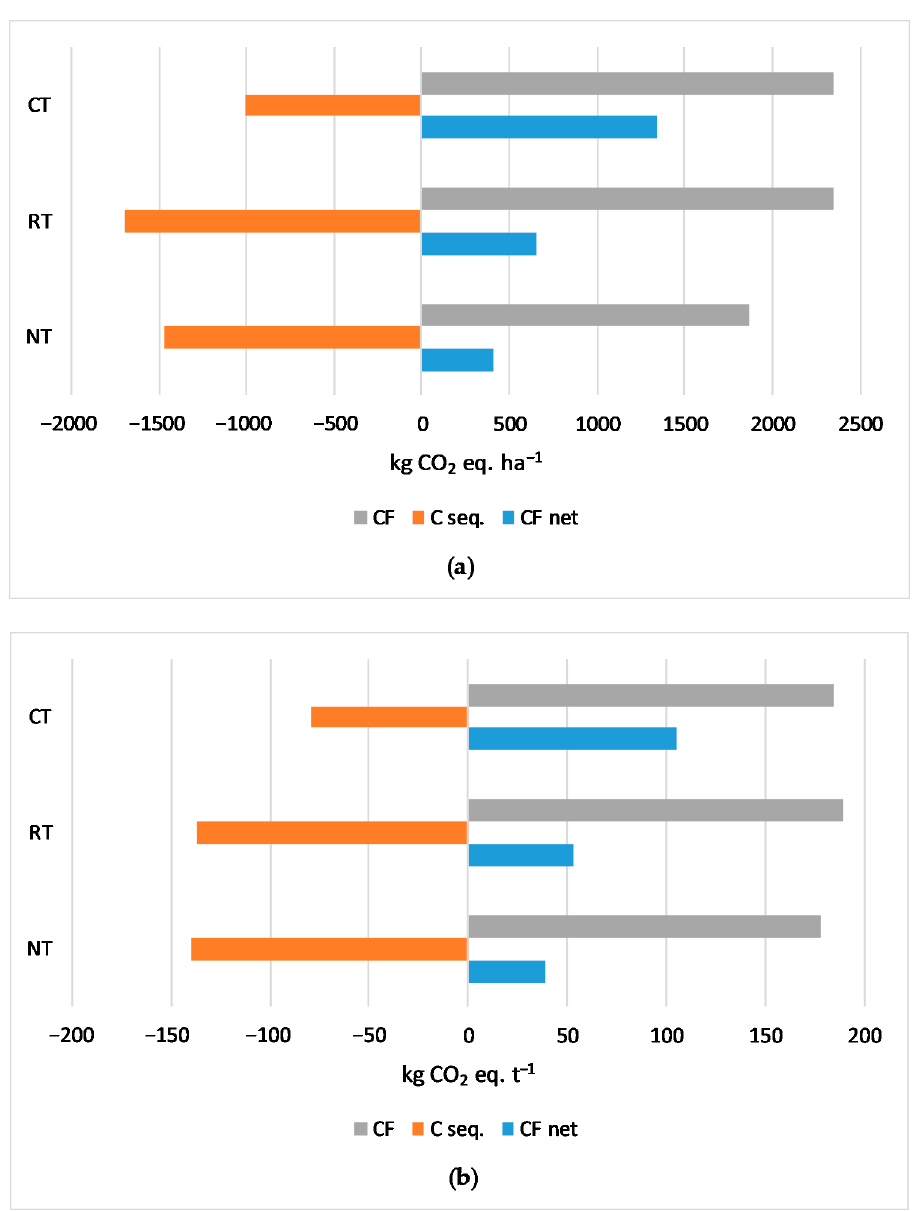
Figure 5. Results of the carbon footprint (CF) and the net carbon footprint (CF net) after inclusion of soil organic carbon sequestration (C seq.) for the grain maize production in conventional tillage (CT), reduced tillage (RT) and no-tillage (NT): ( a ) per one hectare of area; ( b ) per one ton of grain.